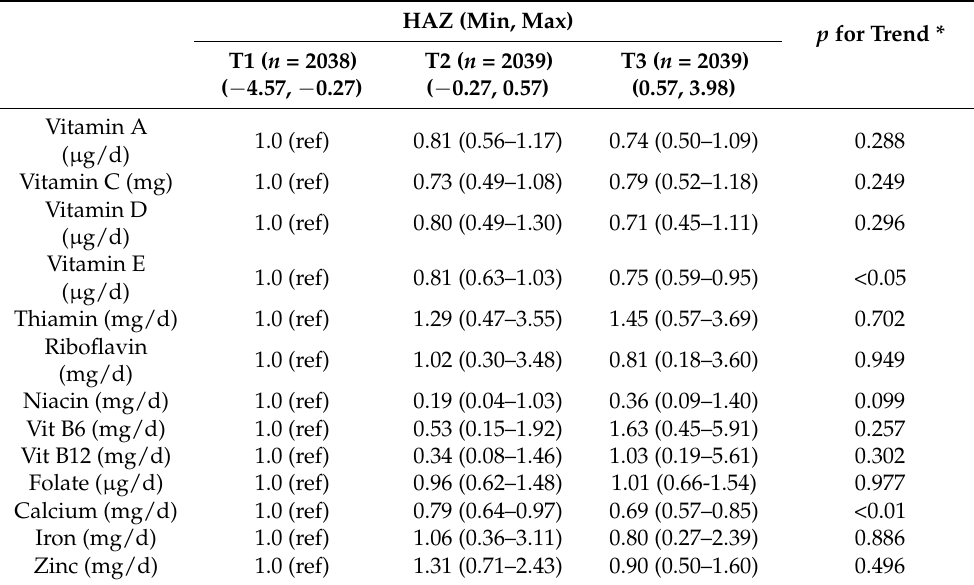
Table 3. Odds ratios and 95% CIs for consuming below the EAR by tertile of HAZ among US children aged 2-18 years in NHANES 2007-2014 ( n = 6116).